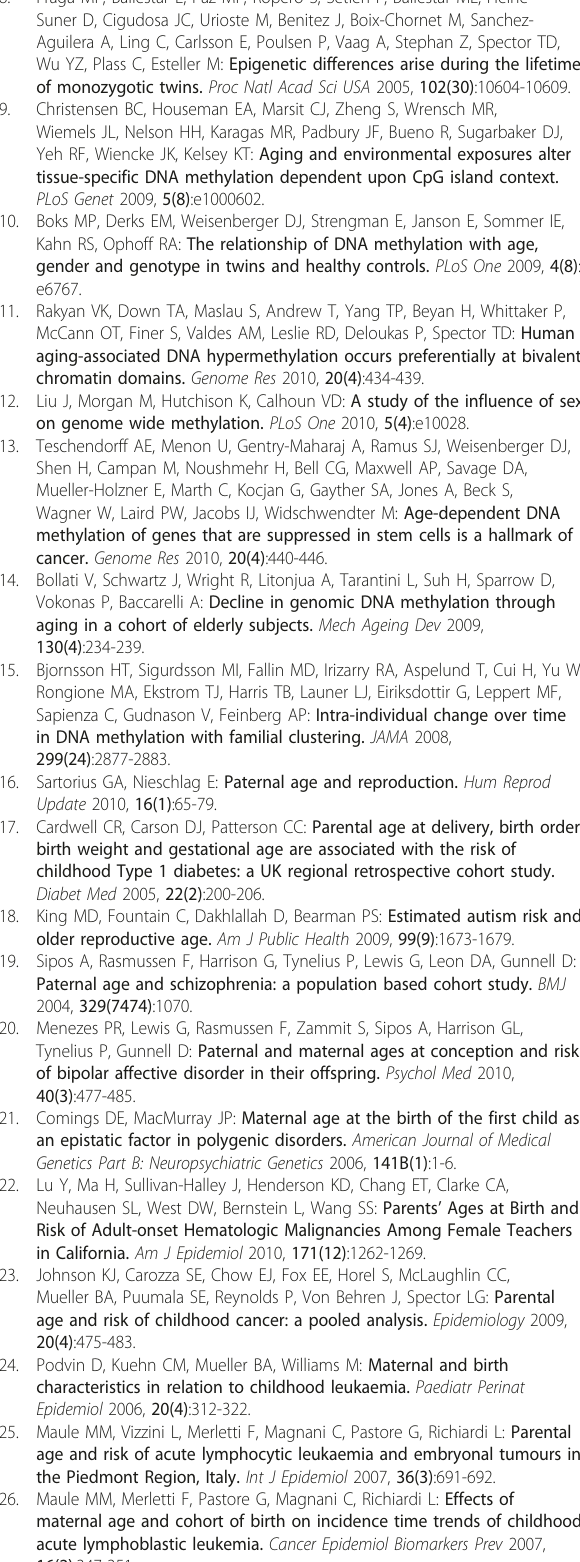
List of abbreviations DAVID: Database for Annotation, Visualization, and Integrated Discovery; DMR: differentially methylated region; OMIM: Online Mendelian Inheritance in Man; CANDLE: Conditions Affecting Neurocognitive Development